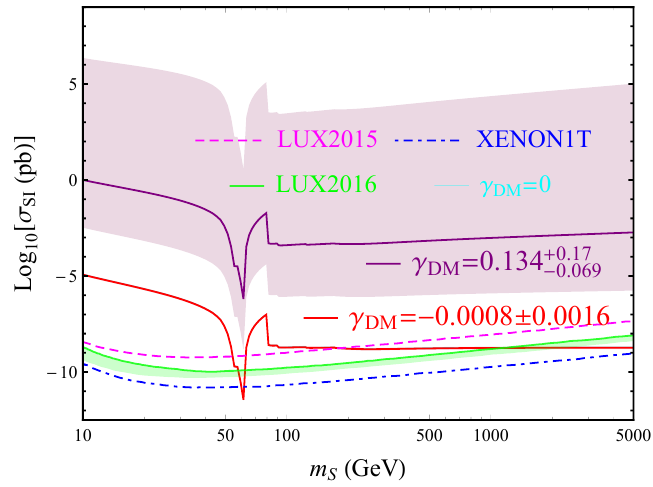
Figure 6 . DM-nucleon scattering cross section σ SI as the function of DM mass for several γ DM . The magenta dashed line, purple line, and blue dot-dashed line represent the bounds from the LUX2015 [108], LUX2016 [108] and Xenon1T [108], respectively. And the purple shad band refers to 2 σ deviation to their central values that were chosen by authors in refs. [104,